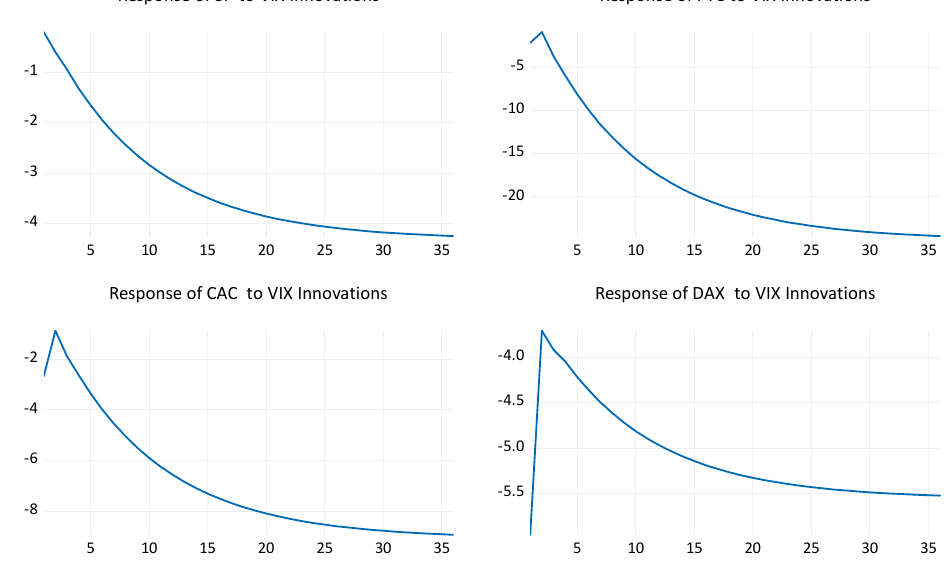
Figure 9. Responses of equity indices to innovations in the VIX from the vector error correction model.